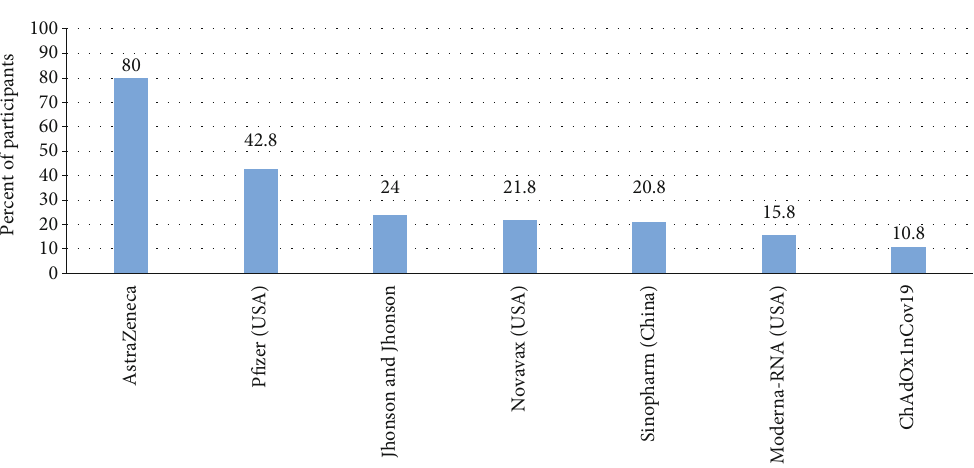
Figure 2: Knowledge of participants about types of COVID-19 vaccines ( n = 400